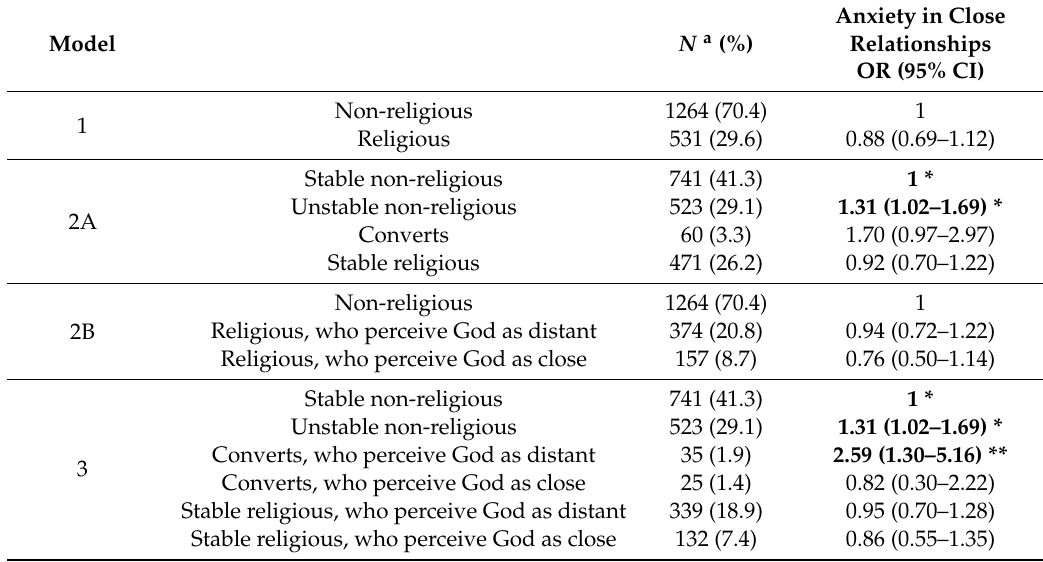
Table 2. Associations of di ff erent religiosity / spirituality (R / S) models with anxiety in close relationships: resultsofbinarylogisticregressionwiththestablenon-religiousrespondentsbeingthereferencecategory, adjusted for age, gender and education level leading to odds ratios with 95% confidence